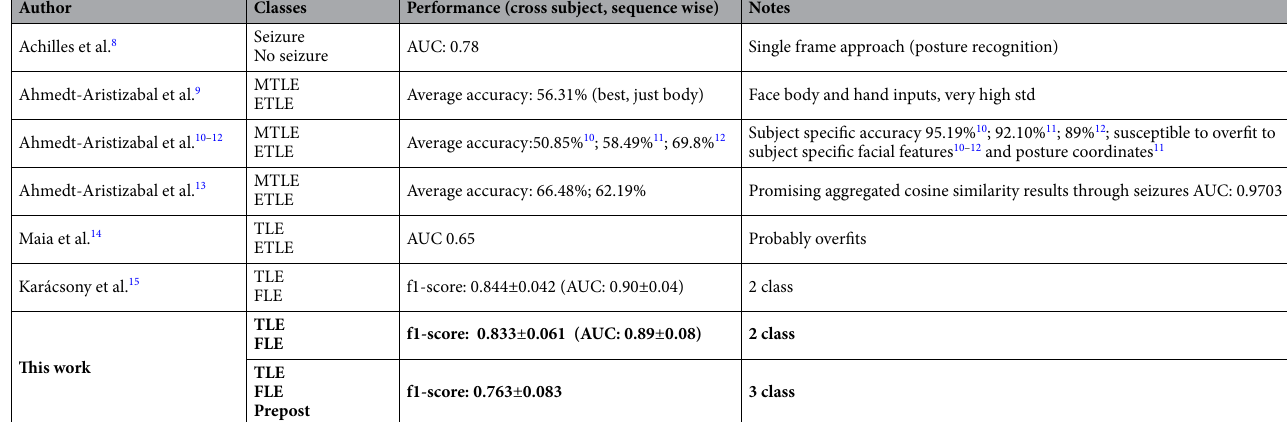
Table 1. Results and comparison. (a) Comparison to other deep learning based publications in this domain. ( ETLE extra temporal lobe epilepsy, MTLE mesial temporal lobe epilepsy, std standard